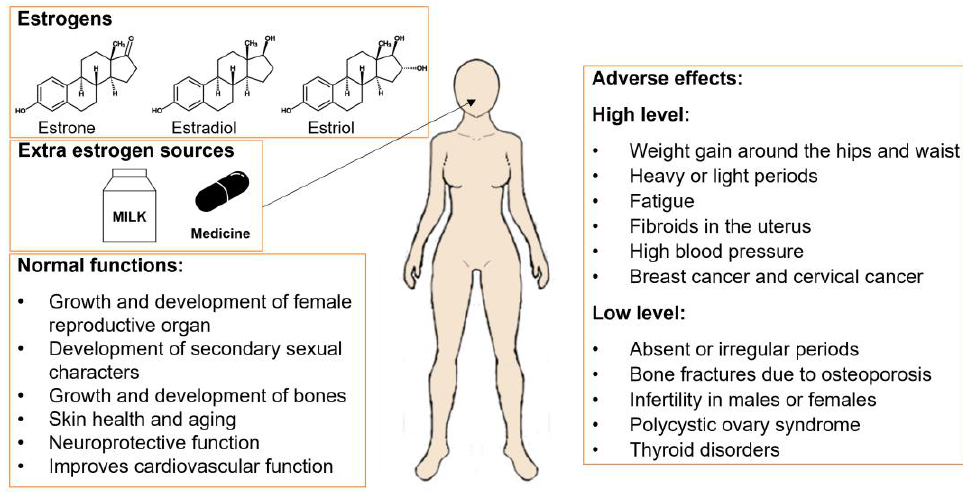
Figure 1. Types of estrogen and role of estradiol.